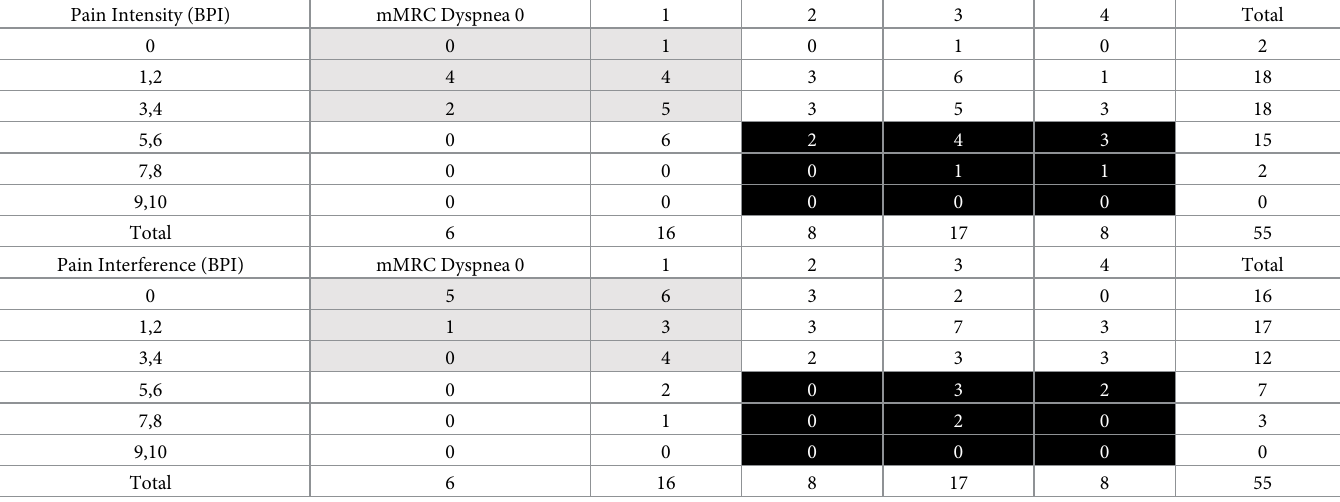
Relationship between the co-occurrence of pain and dyspnea with PA and exercise capacity The co-occurrence of pain (VR-36) and dyspnea (mMRC) was significantly associated with a trend towards lower daily step count and lower 6MWT distance (Table 5A and 5B). Compared to those with no co-occurrence of pain and dyspnea, those with co-occurrence walked, on average, 1,444 (pain amount) to 1,291 fewer steps per day (pain interference). These differ- ences exceed the MCID of 600–1,000 for steps per day [23]. Similarly, compared to those with no co-occurrence, those with co-occurrence had, on average, an 85 m (pain amount) and 80 m Table 4. a and 4b. Frequency of participants with absence of (gray) versus presence of (white and black) co-occurring pain and dyspnea. Pain Intensity